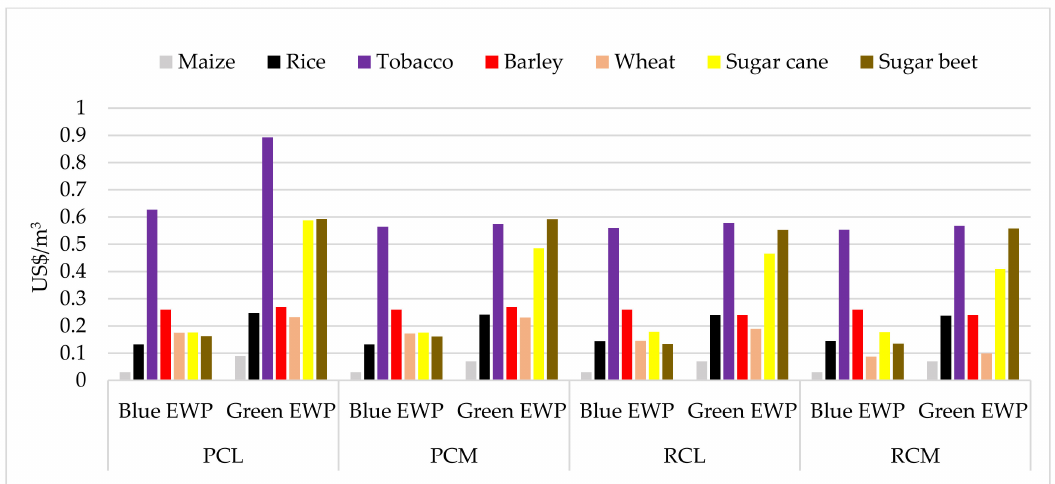
Figure 9. EWP of major crops in different sub-regions of Peshawar Basin. The blue and green EWP of maize and rice were similar in all sub-regions, except PCL. The blue and green EWP of tobacco slightly varied in different sub-regions but was